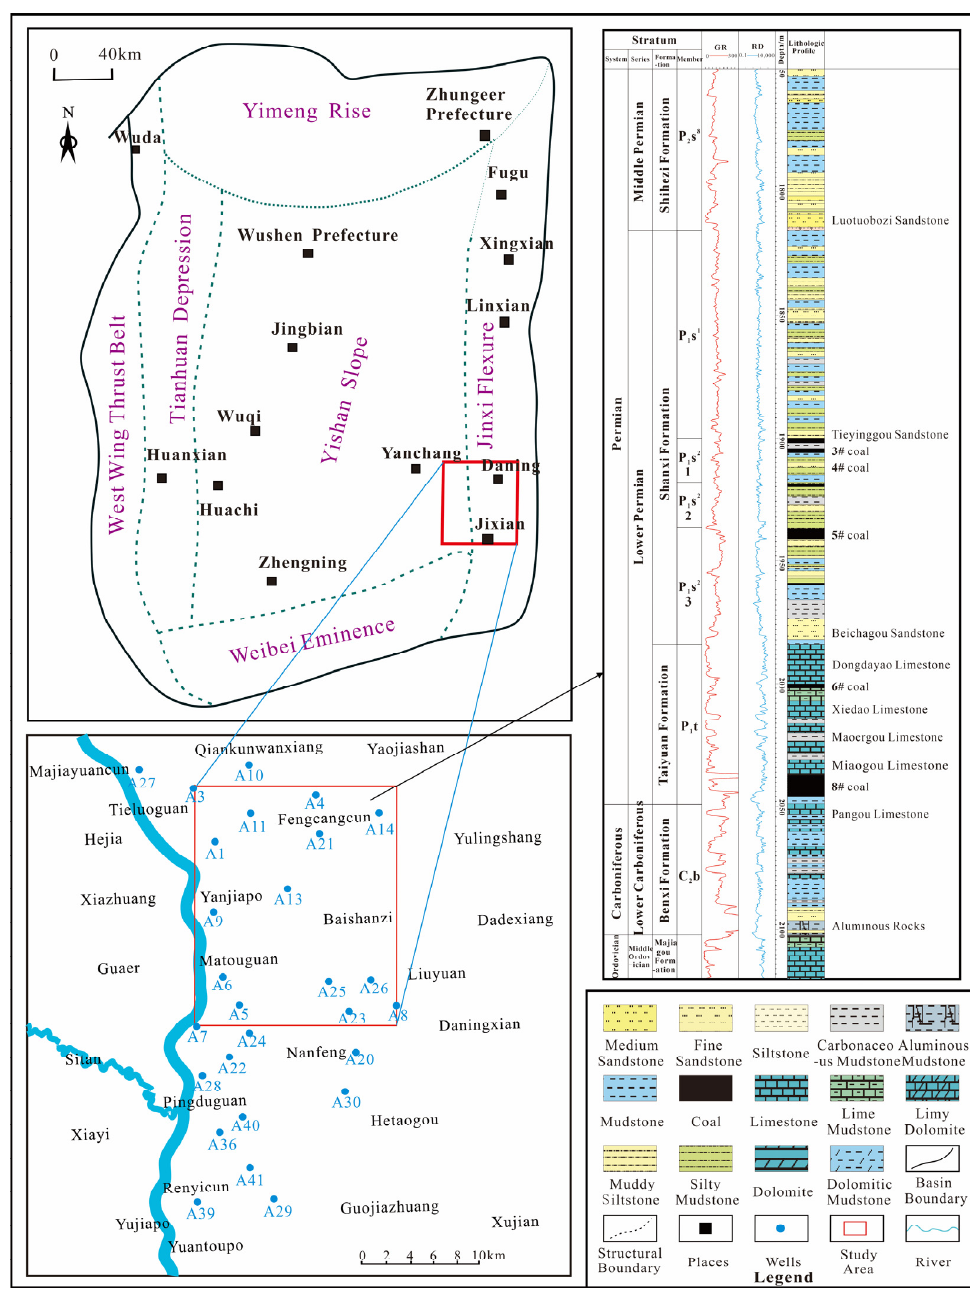
Figure 1. Regional geology and comprehensive histogram of southeastern margin of the Ordos Basin (modified from [29]).